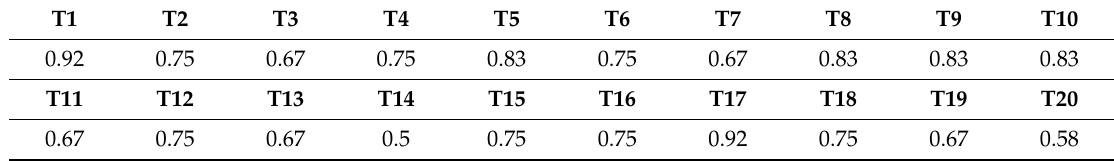
Table 4. A ff ect recognition rate of system for each image-content